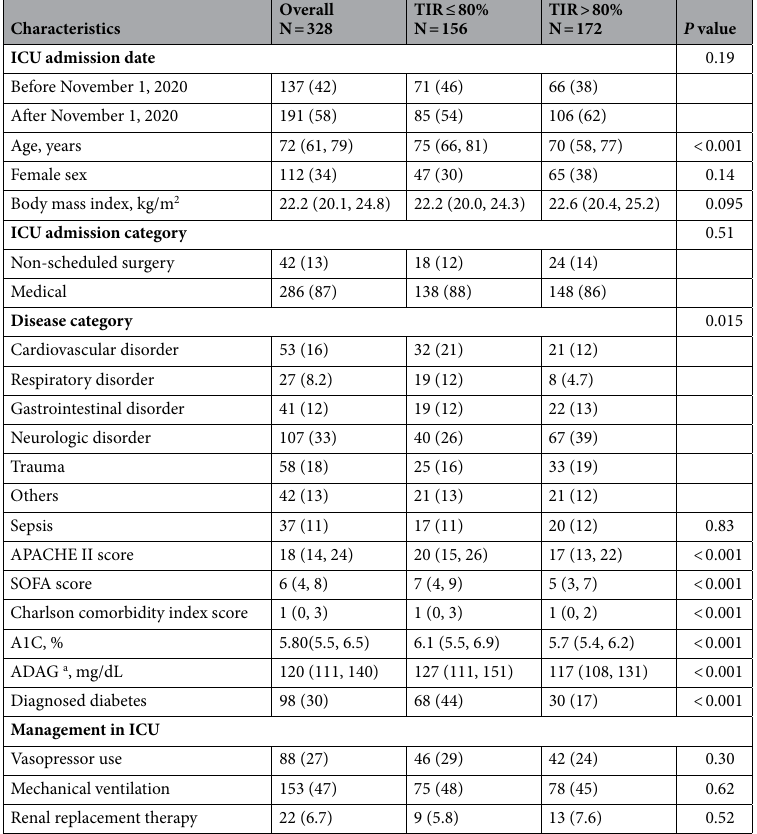
Table 1. Basic characteristics: TIR of relative normoglycemia ≤ 80% vs. > 80%. Data are expressed as median (interquartile range) or number (%). TIR time in range, APACHE Acute Physiology and Chronic Health Evaluation, SOFA Sequential Organ Failure Assessment, ADAG A1C-derived average glucose. a A1C-derived average glucose (mg/dL) can be obtained from the following formula: 28.7 × A1C (%) −